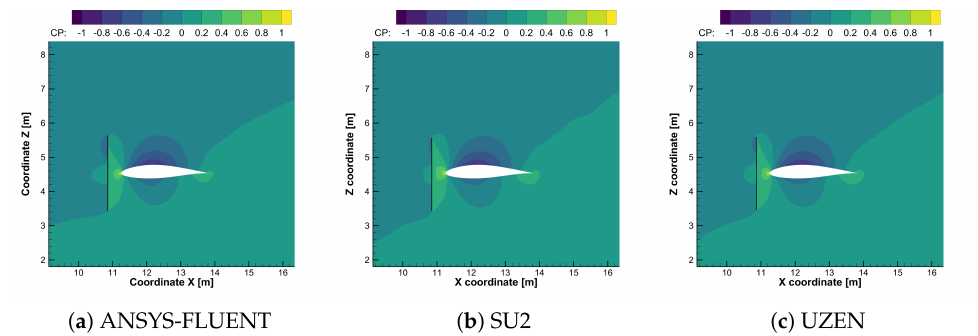
Figure 21. Pressure coefficient contour for power-on condition at α = 0 ◦